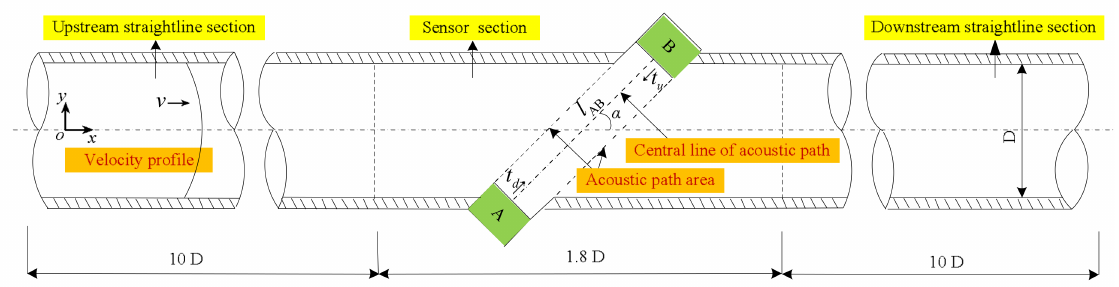
Figure 1. Schematic of the ultrasonic